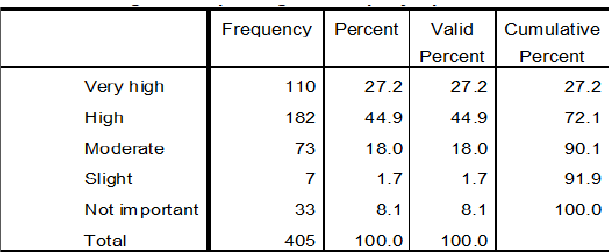
Figure 1. What is the level of importance of IoT and cloud based technologies in improving the company’s performance